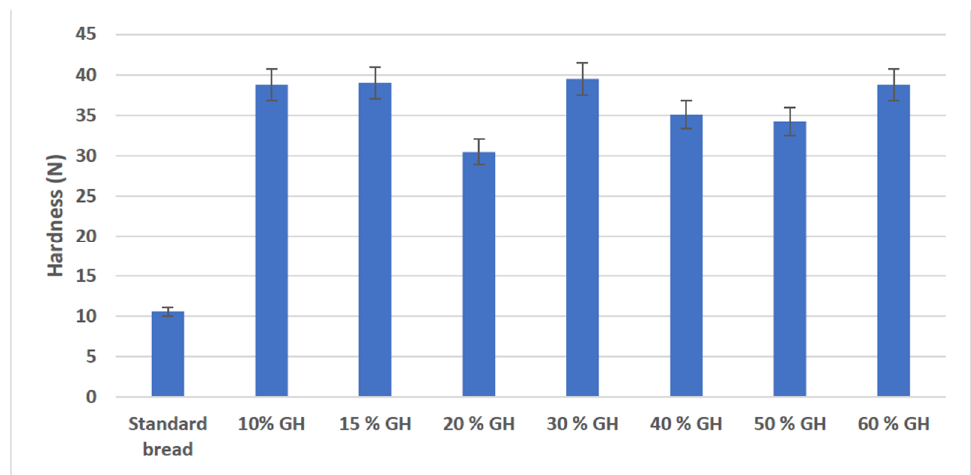
Figure 3. Hardness profile of standard bread vs gas hydrates bread is shown as bar graphs with standard deviation; the x-axis represents the various combinations of GH bread compared with standard bread while the y-axis shows the hardness values of bread in newton. Table 3. Texture profile analysis of standard bread versus the GH bread.